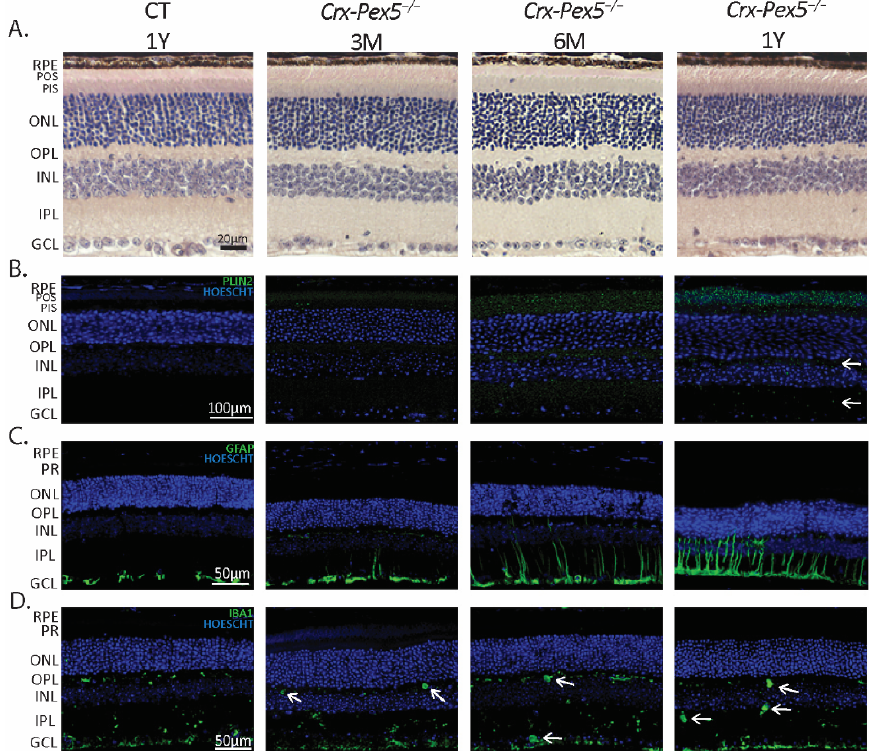
Figure 8. Retinal phenotype of Crx-Pex5 − / − mice. ( A ) HE staining showed no morphological differences between CT and Crx-Pex5 − / − mice at any investigated age. ( B ) Lipid droplet staining revealed a gradual increase in lipid droplets in the POS, PIS, OPL (white arrows), IPL (white arrows) and GCL in Crx-Pex5 − / − mice. ( C ) Activated Müller cells were observed starting from the age of 3 M, with progressive sprouting into the neural retina at later time points. ( D ) Microglia are swollen and reactive both in the OPL and IPL (white arrows) from 3 M of age. N = 4/group. RPE—retinal pigment epithelium; PR—photoreceptor; POS—photoreceptor outer segments; PIS—photoreceptor inner segments; ONL—outer nuclear layer; OPL—outer plexiform layer; INL—inner nuclear layer; IPL— inner plexiform layer; GCL—ganglion cell layer; GFAP—glial fibrillary acid protein; IBA1—ionized calcium binding adaptor molecule 1; PLIN2—perilipin 2.